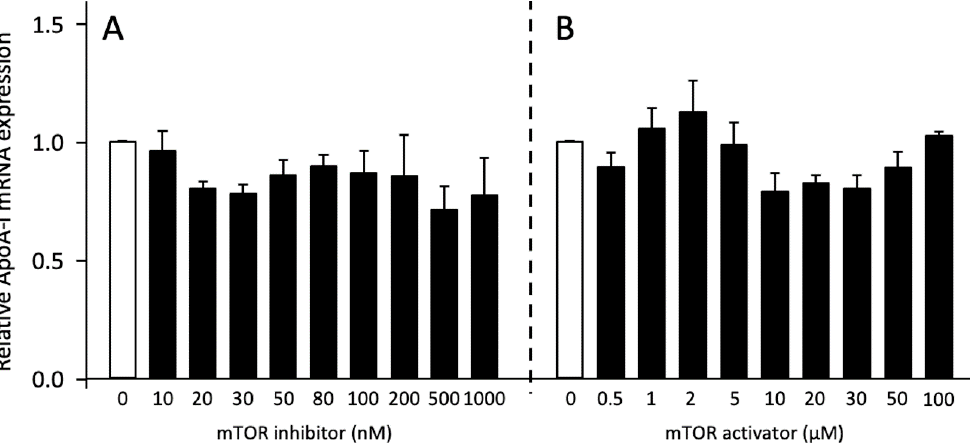
Figure 6. Effects of mTOR inhibition and activation on ApoA-I mRNA expression. HepG2 cells were